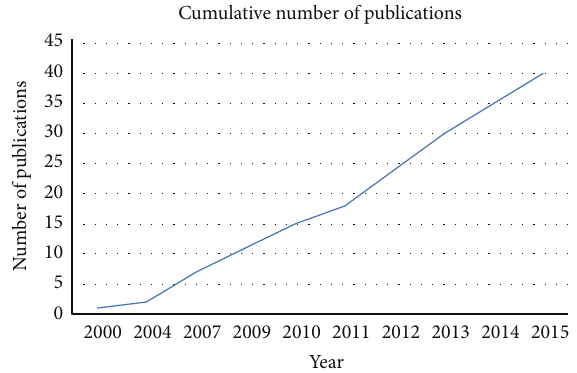
Figure 1: Cumulative number of publications over years. Publica- tion trend from January 2000 until April 2015 on studies performing both in vitro and in vivo tendon tissue